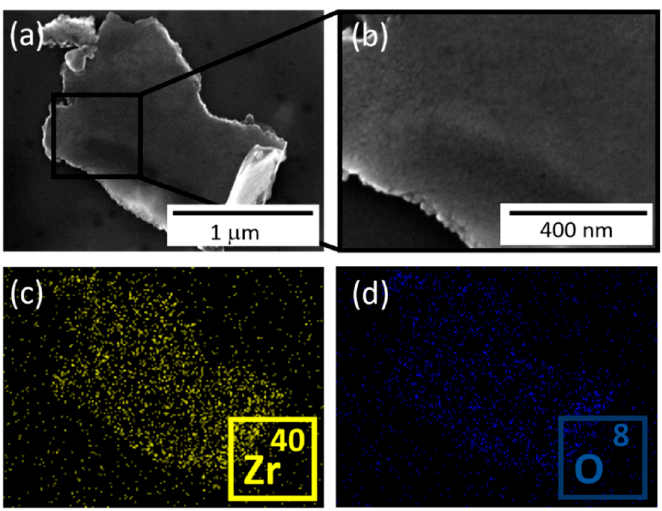
Figure 8. ( a , b ) SEM images of the ZrO 2 particle produced by the combustion synthesis method and after annealing in air at 350 °C for 1 h, together with the corresponding EDS maps of Zr ( c ) and O ( d ). The atomic percentages of Zr and O were also estimated by EDS point analysis (Table 2).